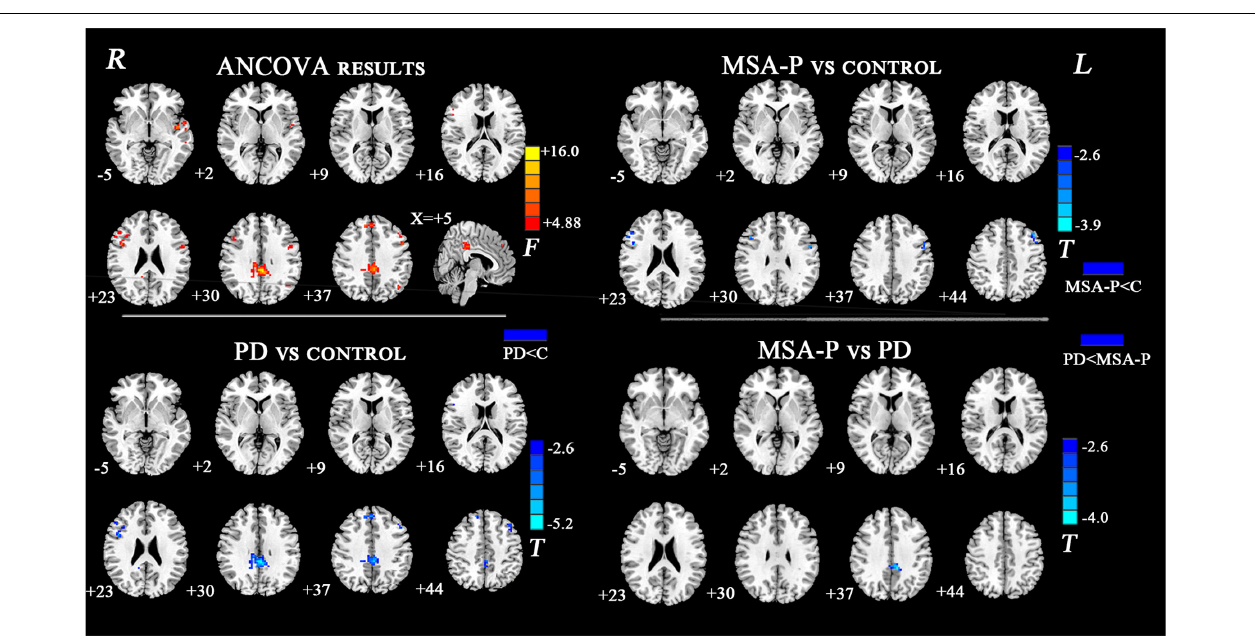
FIGURE 2 | Statistical maps showing FC differences of right DN in different brain regions among the MSA-P, PD, and control groups. The threshold for display was set to p < 0.01 corrected by AlphaSim; Results are in MNI space; Red color represents the increased correlation while the blue color represents the decreased correlation; R, right; L, left; C,